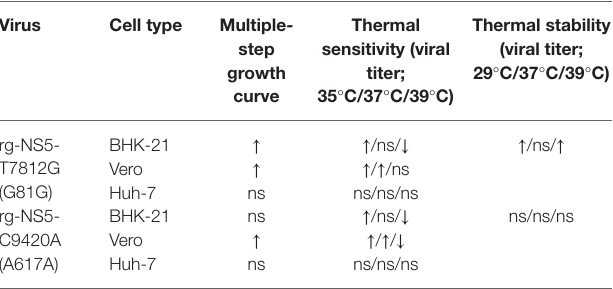
TABLE 2 | Summary of